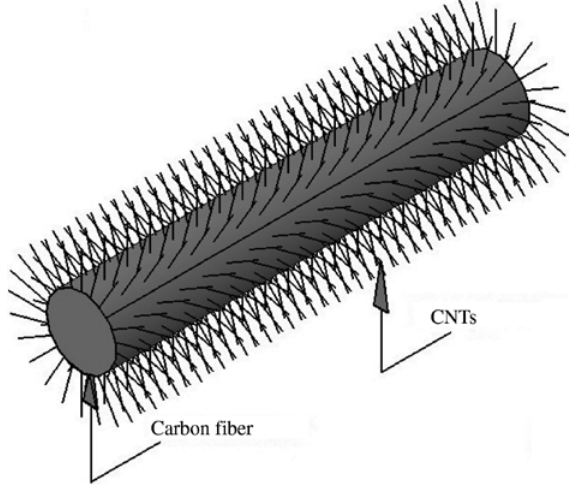
Figure 2: In-plane cross-section of hybrid nanocomposite lamina.